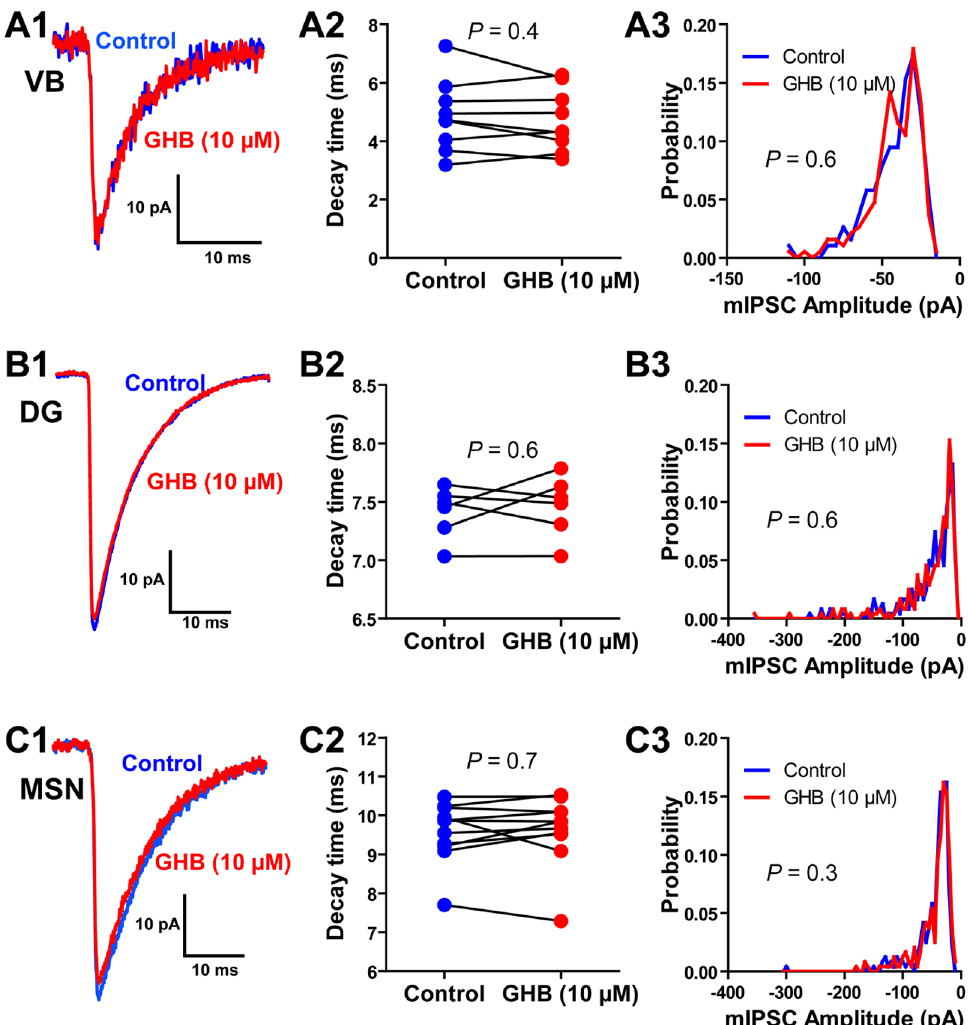
Figure 2. GHB has no effect on synaptic GABA A receptors. A1 , Representative average mIPSC from a VB thalamic neuron before and after application of GHB. A2 , GHB has no effect on the decay time constants of averaged mIPSCs in VB neurons. A3 , Distribution of mIPSCs amplitude across 9 cells, showing no effect of GHB. B1 , Representative average mIPSC from a dentate gyrus (DG) granule cell before and after application of GHB. B2 , GHB has no effect on the decay time constants of averaged mIPSCs in dentate gyrus granule cells. B3 , Distribution of mIPSCs amplitude across 6 cells, showing no effect of GHB. C1 , Representative average mIPSC from a striatal medium spiny neuron (MSN) before and after application of GHB. C2 , GHB has no effect on the decay time constants of averaged mIPSCs in medium spiny neurons. C3 , Distribution of mIPSCs amplitude across 11 cells, showing no effect of GHB.